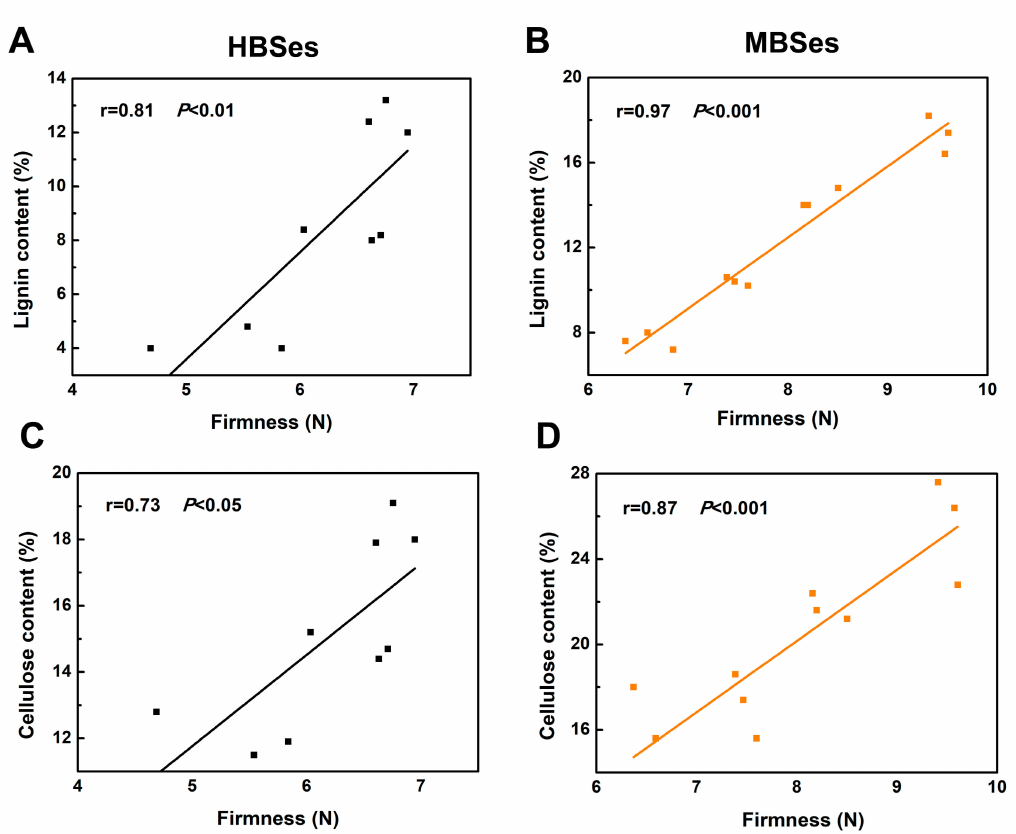
Figure 3. Scatterplots between firmness and lignin and cellulose contents in HBSes and MBSes at room temperature. ( A ) Linear regression analysis between firmness and the lignin content in HBSes. ( B ) Linear regression analysis between firmness and the lignin content in MBSes. ( C ) Linear regression analysis between firmness and the cellulose content in HBSes. ( D ) Linear regression analysis between firmness and the cellulose content in MBSes. Significant di ff erences were determined using SPSS Statistics